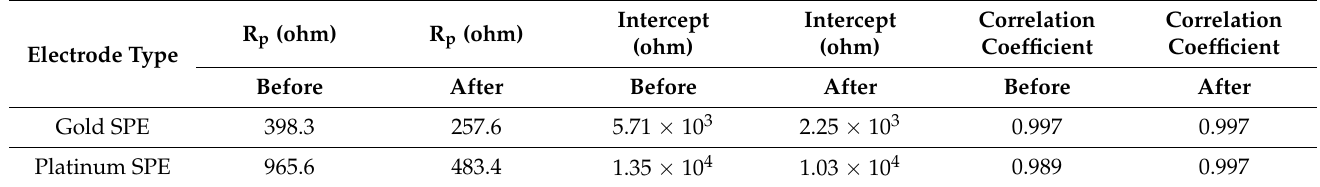
Table 2. EIS measurements for polarization resistance R p , gradient, intercept (sum between the charge of the double layer Q dl and the charge of the species of the solution Q i ) and correlation coefficient r, before and after degreasing with acetone, frequency range 0.1 mHz ÷ 100 kHz in a 5 mM solution of K 4 [Fe(CN) 6 ]/K 3 [Fe(CN) 6 ] .